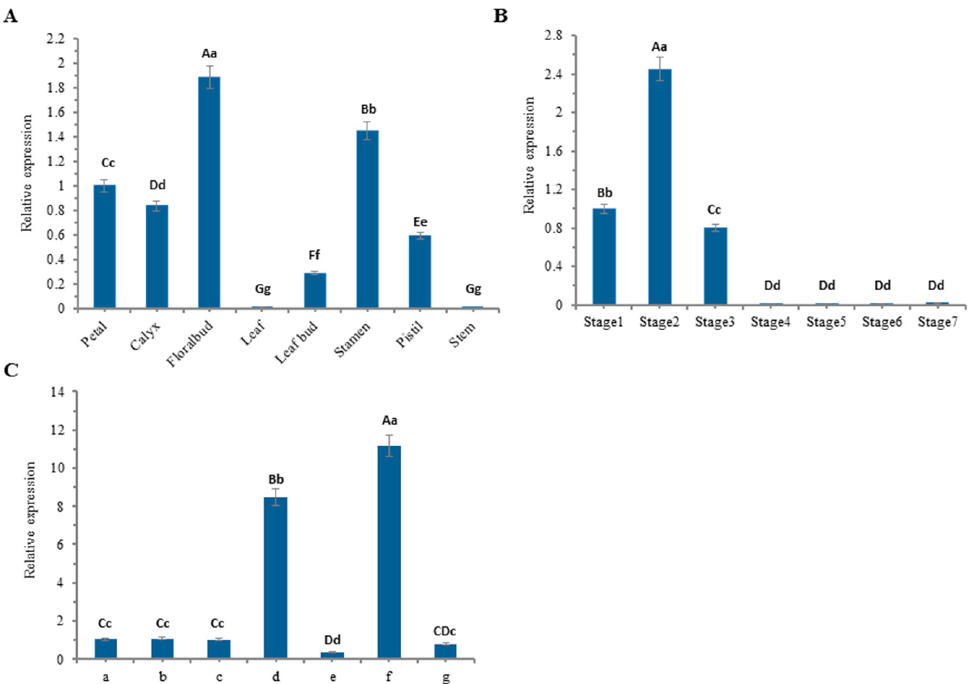
Figure 4. Quantitative RT-PCR analysis of transcript levels of LtuJAG in L. tulipifera . LcACTIN97 gene was used as an internal control to normalize the values of target transcripts. ( A ) Transcript levels of LtuJAG in different tissues; ( B ) Transcript levels of LtuJAG at different stages of leaf de- velopment; Stage 1–2: leaf bud growth stage; Stage 3: young leaf stage; Stage 4–6: mature stage; Stage 7: senescence stage; ( C ) Transcript levels of LtuJAG at different parts of leaf in L. tulipifera , a, c and e: leaf tooth tip, b and d: leaf tooth sinus, g: middle of leaf, f: petiole. Date represented the means (±SD) from the three replicates, and the error bars represent the standard deviation between the replicates. Data were analyzed statistically using the one-way ANOVA Tukey’s test. Different letters indicate significant differences at p < 0.01 and p < 0.05 level.